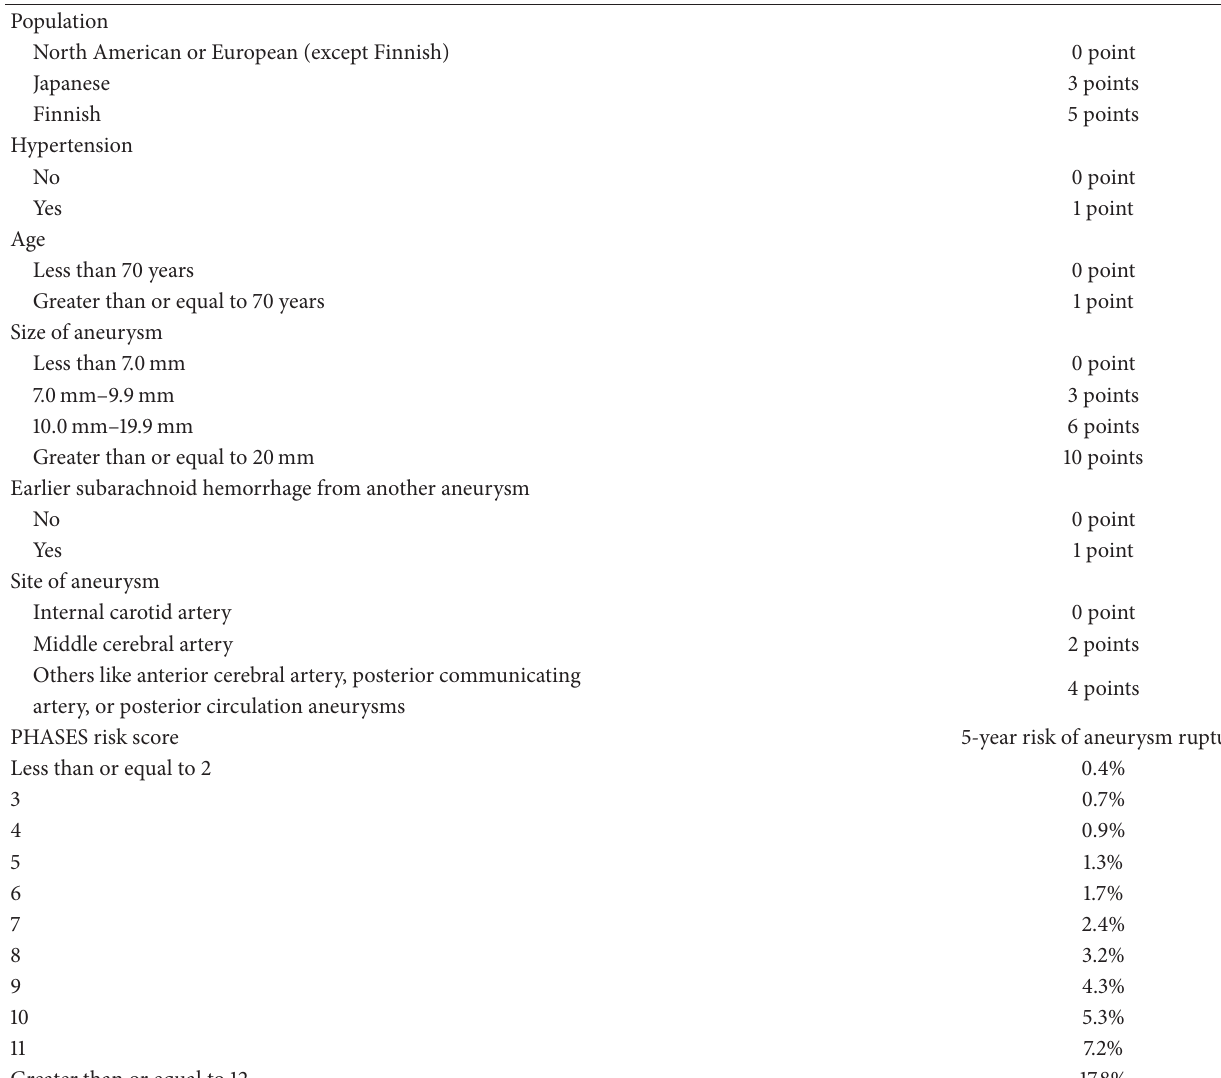
Table 1: PHASES aneurysm risk score